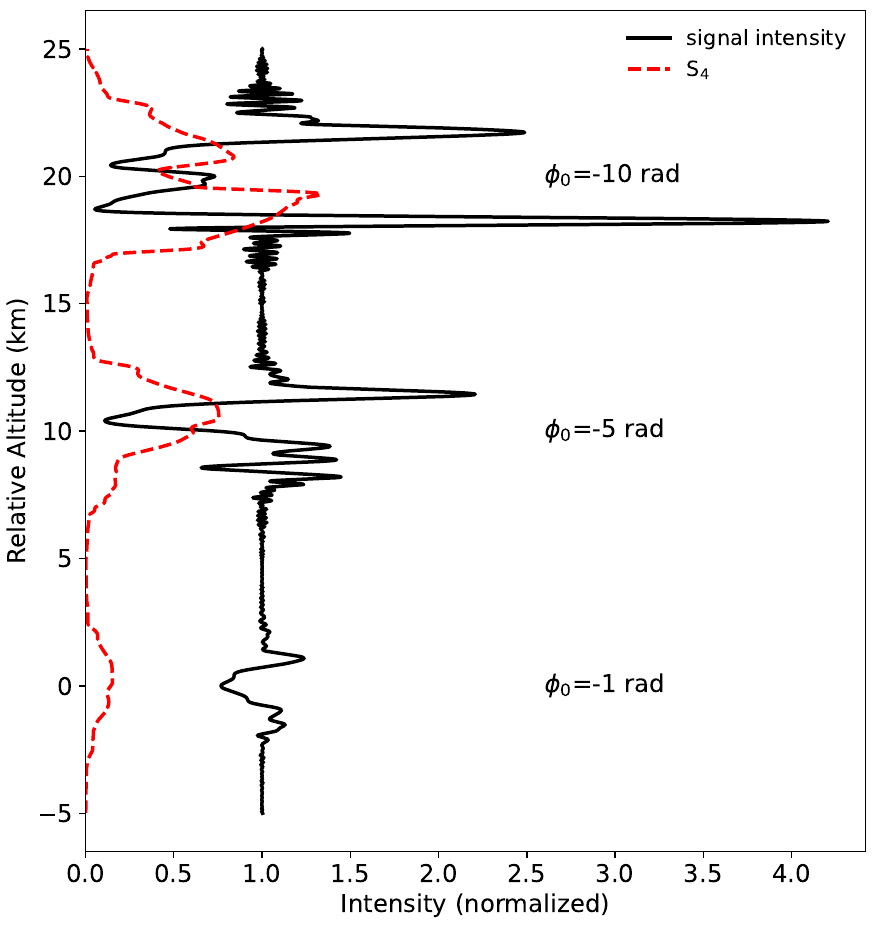
Figure 8. Same as Figure 4 but with the inclusion of turbulence. Additionally, a 2.5 km vertical thickness was used to clearly show the turbulent